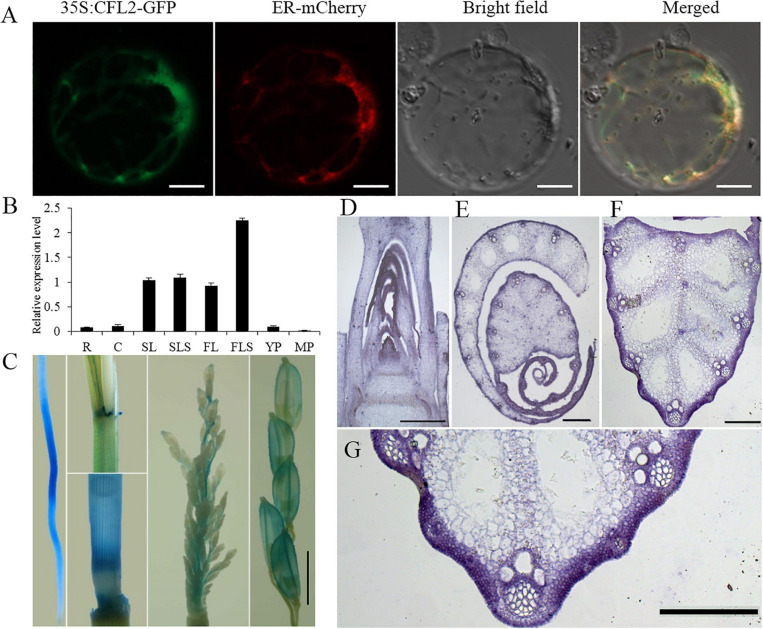
Protein subcellular localization and expression pattern of CFL2. (A) Subcellular localization of CFL2–GFP fusion protein in rice protoplasts. Scale bars = 10 μm. (B) qRT-PCR analysis of CFL2 in various organs, including the root (R), culm (C), second leaf (SL), second leaf sheath (SLS), flag leaf (FL), flag leaf sheath (FLS), young panicle (YP), and mature panicle (MP). Values are means ± SD (n = 3). (C) GUS stains in root, leaf sheath, culm, young panicle, and mature panicle. Scale bar = 2 mm. (D–H)
In situ hybridization analysis of CFL2 expression in SAM (D), leaf (E), leaf vein (F), its partial enlarged drawing (G), and the control tissue using a sense probe (H). Scale bars = 1 cm (D–G) and 2 cm (H).